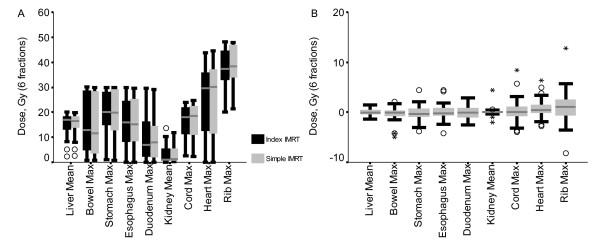
Nominal normal tissue dose for the index and simple IMRT plans showing the median, interquartile range (box), and range (whiskers or stars (outliers)) (A) and differences between individual plans for these structures (B).